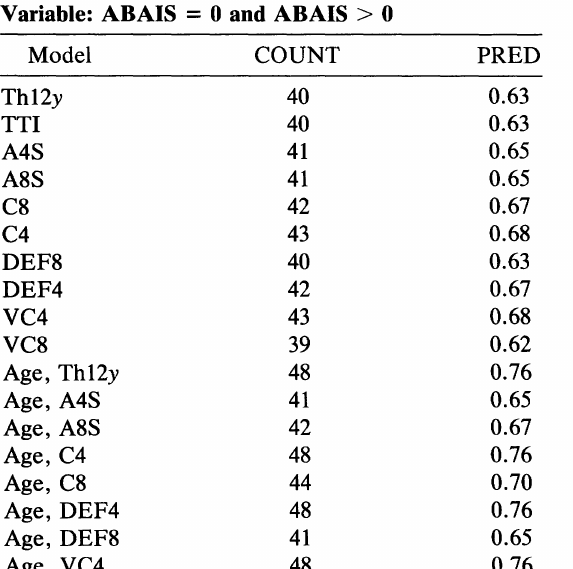
Table 4. Probability Analysis with Dichotomous